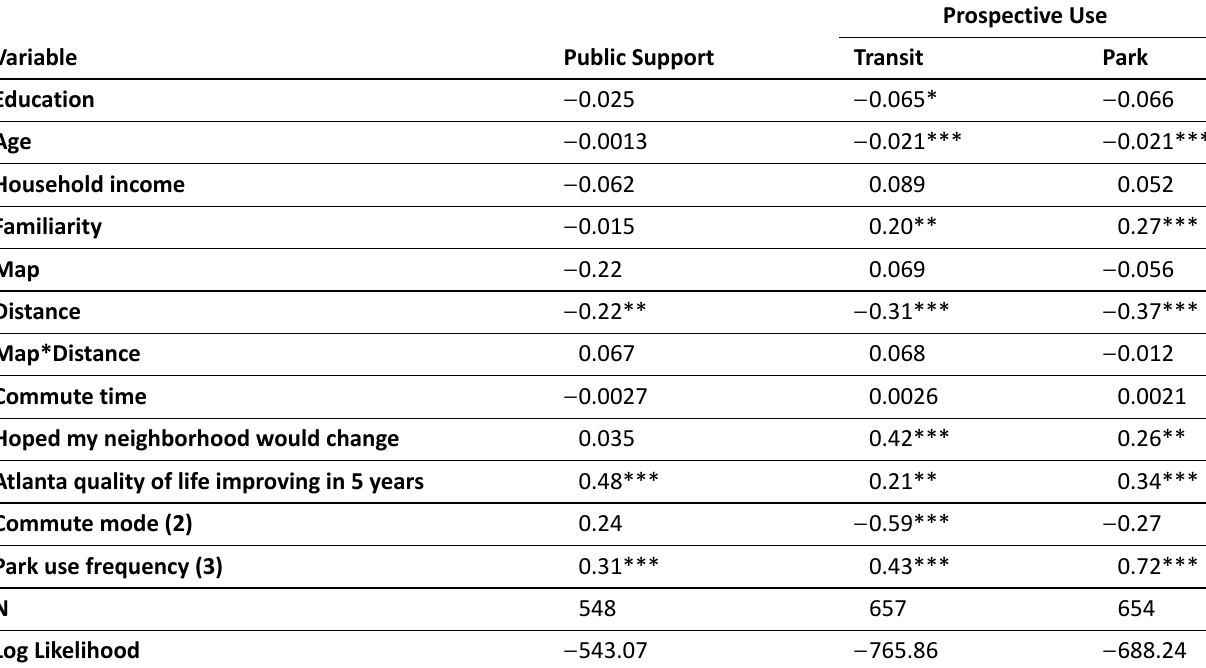
Table 5. Ordered logit regression results for public support and prospective use of the